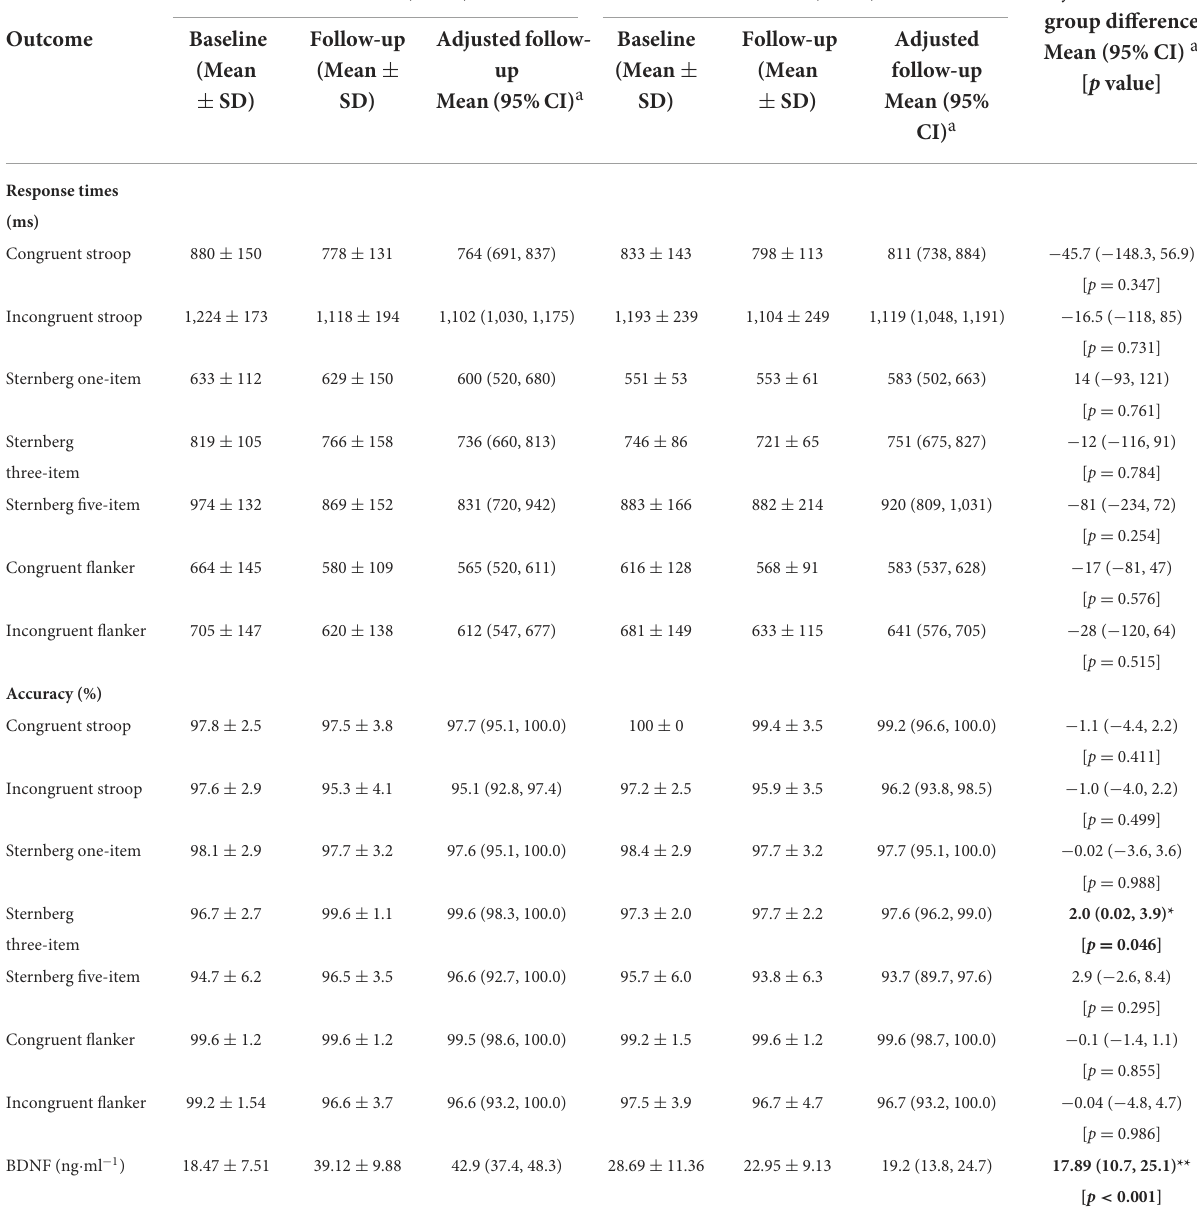
TABLE 5 Baseline and follow-up results of cognitive function outcomes, with data presented as mean ± SD. Intervention ( n =